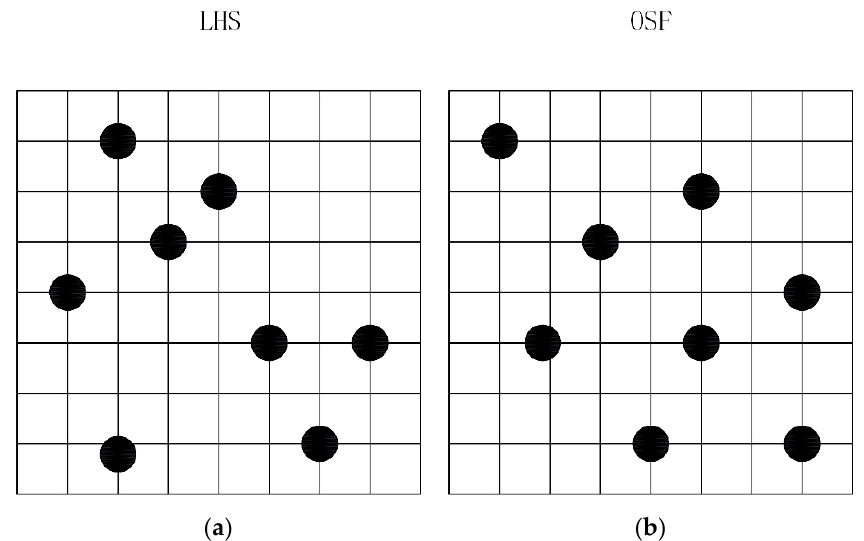
Figure 5. Design of experiments ( DOE) method. ( a ) Latin hypercube sampling algorithm (LHS); ( b ) OSF.